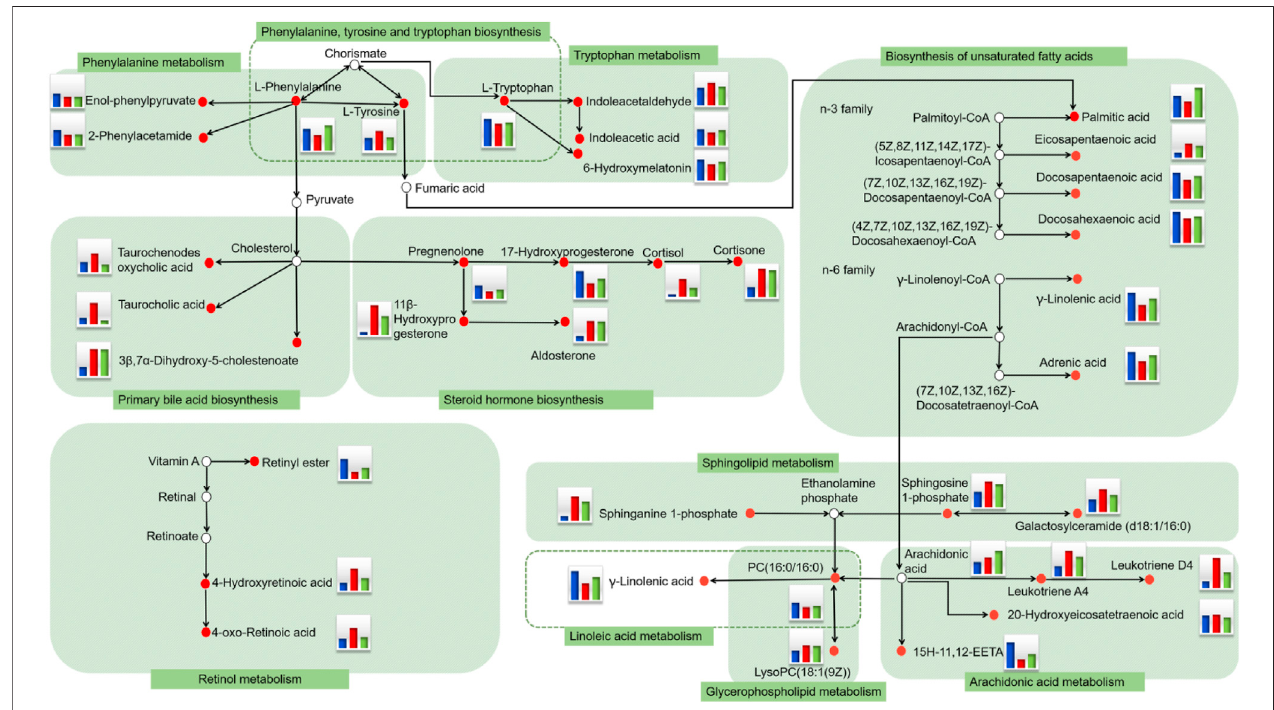
FIGURE 5 | Serum metabolic network of potential DR biomarkers after oral administration of KLX based on the KEGG pathway database. The small red circle represents the biomarker detected in the study. The histogram represents the level of metabolites in the blood. Blue represents the control group, red represents the model group, and green represents the KLX-treated group. DR, diabetic retinopathy; KLX, keluoxin; KEGG, Kyoto Encyclopedia of Genes and Genomes.